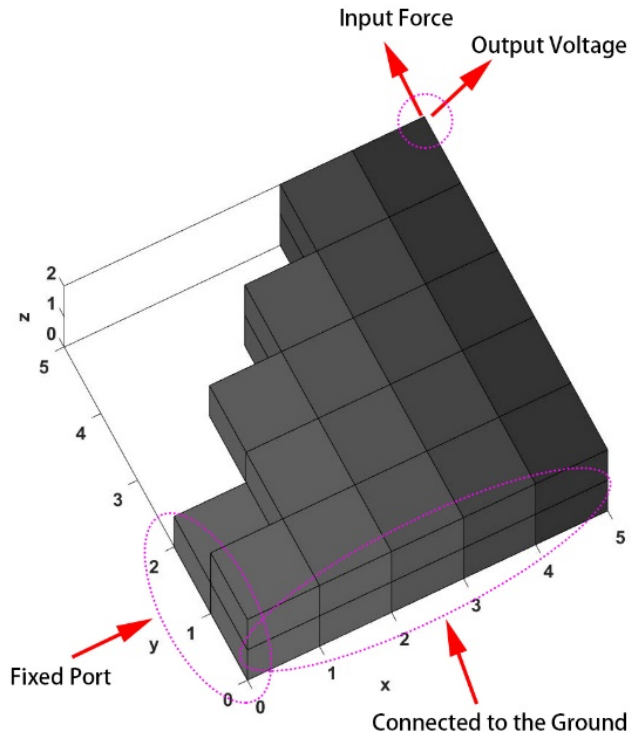
Figure 5. 3D model of the piezoelectric harvester.